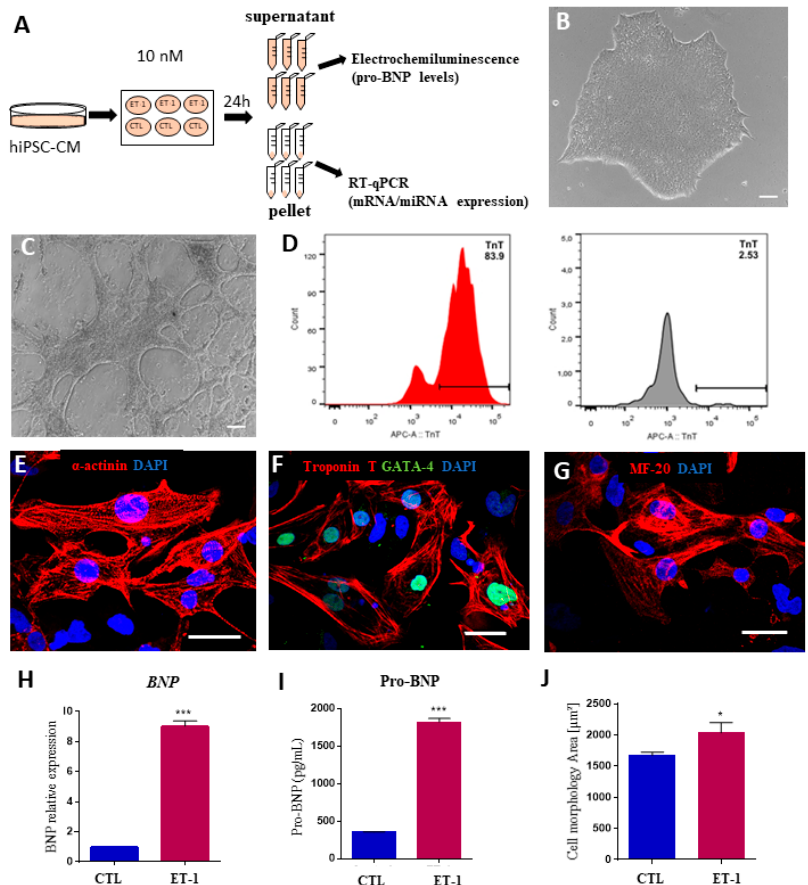
Figure 5. Validation of an in vitro hypertrophy model using human induced pluripotent stem cell-derived cardiomyocytes stimulated with endothelin-1. ( A ) Experimental design. ( B – G ) Characterization of hiPSC-CM. Morphology of hiPSCs visualized by phase-contrast microscopy at di ff erentiation D0 ( B ) and D14 ( C ). ( D ) Di ff erentiation e ffi ciency measured by flow cytometry analysis of cTNT + cells. Histograms show di ff erentiated cells on the left (red histogram) and undi ff erentiated hiPSCs on the right (grey histogram). Scale bars = 100 µ m. ( E – G ) Immunostaining for cardiomyocyte markers sarcomeric alpha-actinin ( E ), cardiac troponin T and GATA-4 ( F ), and MF-20 ( G ). Scale bars = 50 µ m. ( H ) Increased BNP expression at the mRNA level, evaluated by RT-qPCR and at the protein level in the ( I ) culture supernatant 24 h after ET-1 incubation. ( J ) Cardiomyocyte area measured by quantification of cTNT staining. CTL = unstimulated hiPSC-CMs, ET1 = hiPSC-CMs stimulated with ET-1. Values represent the mean ± SEM of n = 3 replicates group and were evaluated using Student’s t -test. * p < 0.05 and *** p < 0.001.